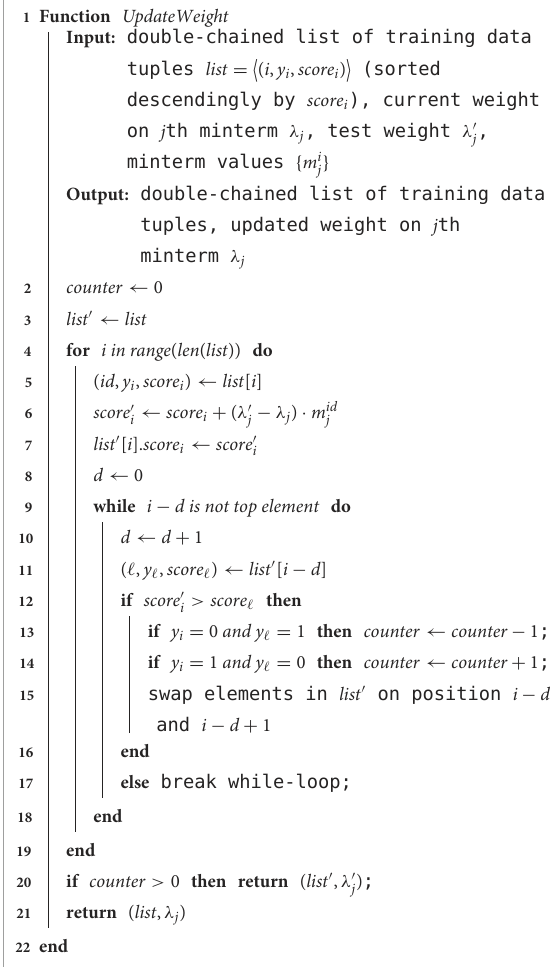
Algorithm 2. Update of j th minterm weight λ j